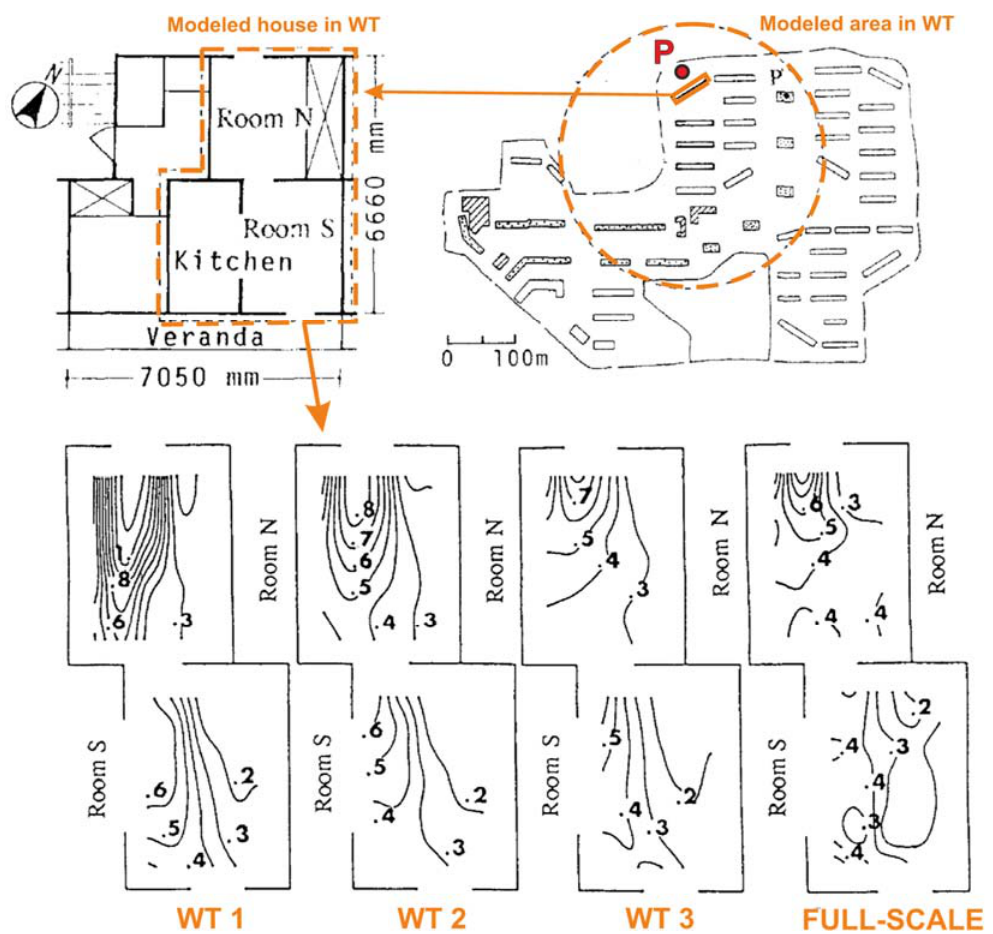
Figure 2. Internal Reynolds number independence test within a dairy building for two wind tunnel freestream velocities: 8 m/s (left) and 12 m/s (right). Note that the streamlines (lines with arrows) do not change significantly with the change in the approach wind speed (freestream velocity). Adapted from [26] ‐ Copyright 2018, Elsevier.